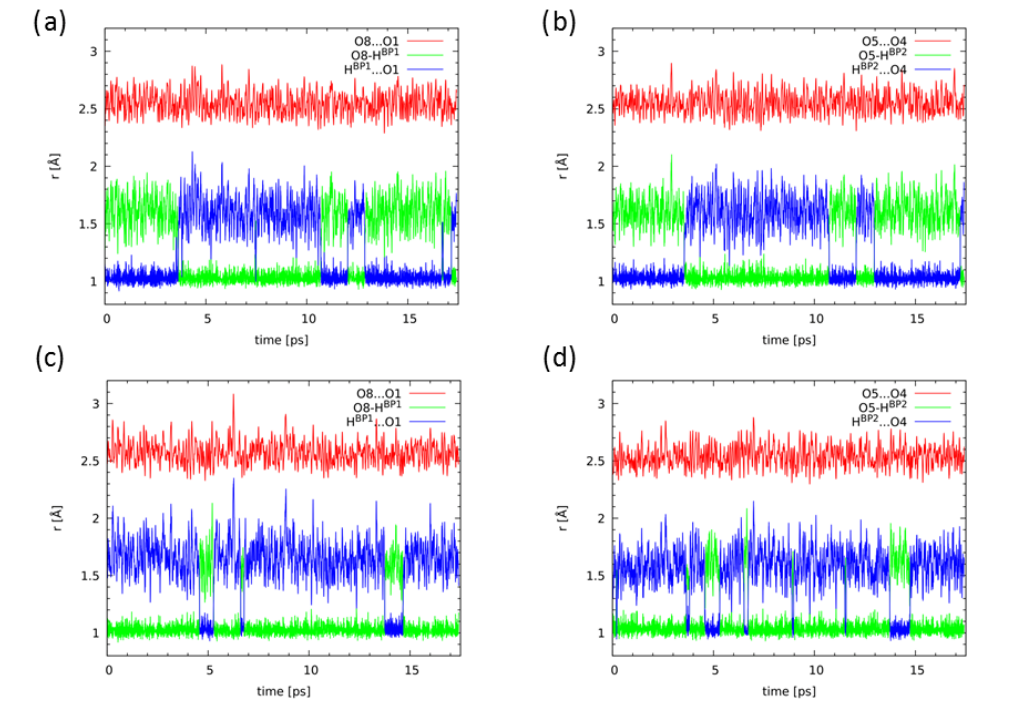
Figure 8. Time evolution of the metric parameters of the hydrogen bridges. Results of the CPMD simulation at 300 K: ( a ) gas phase, bridge 1; ( b ) gas phase, bridge 2; ( c ) solid state, bridge 1; ( d ) solid state, bridge